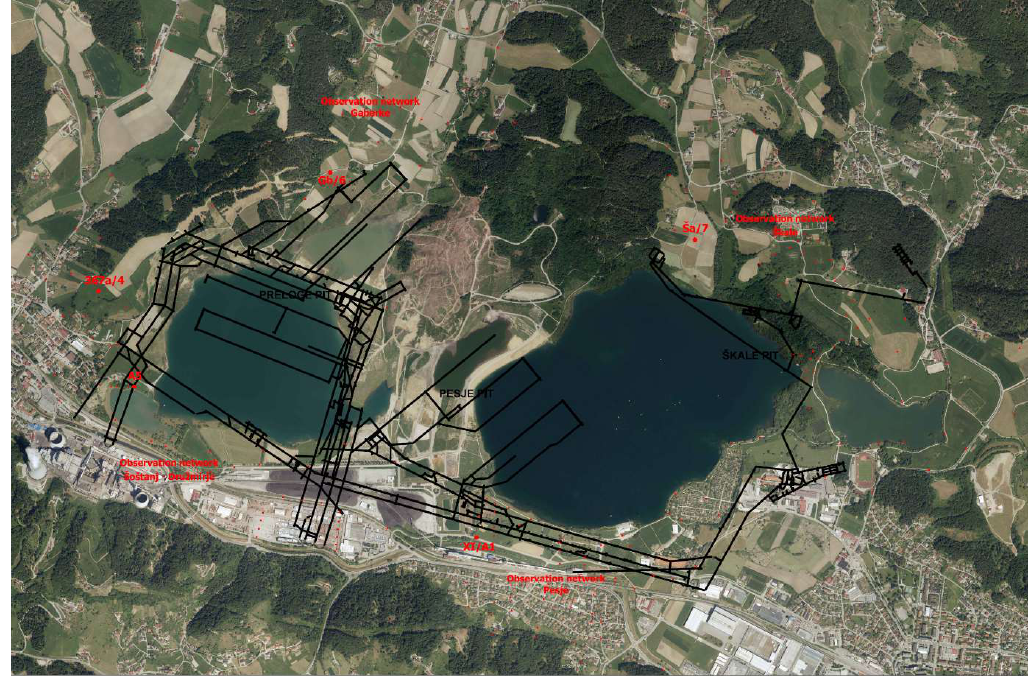
Figure 2. The broader area of the Velenje Coal Mine showing the mine roadways (black) and points of observation networks on the surface (red).